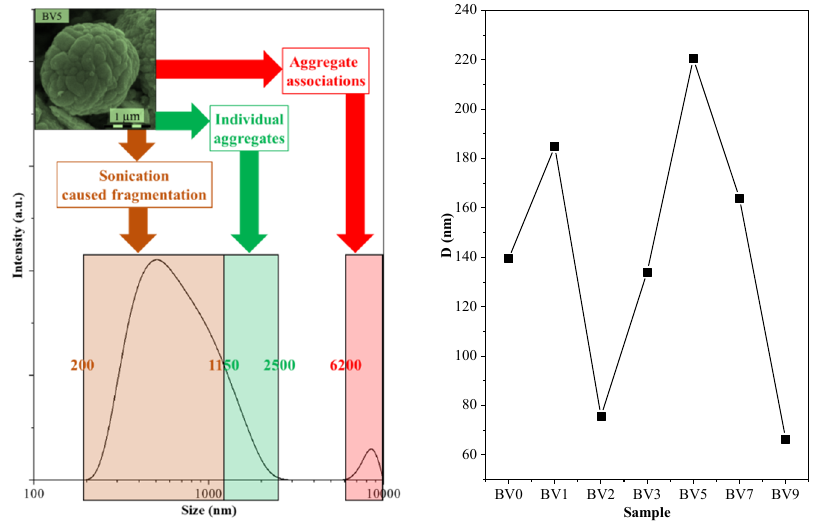
Figure 9. The size distribution of sample BV5, measured by DLS, showing a bimodal size distribution. The sample (synthesis pH) dependence of the hydrodynamic particle size.